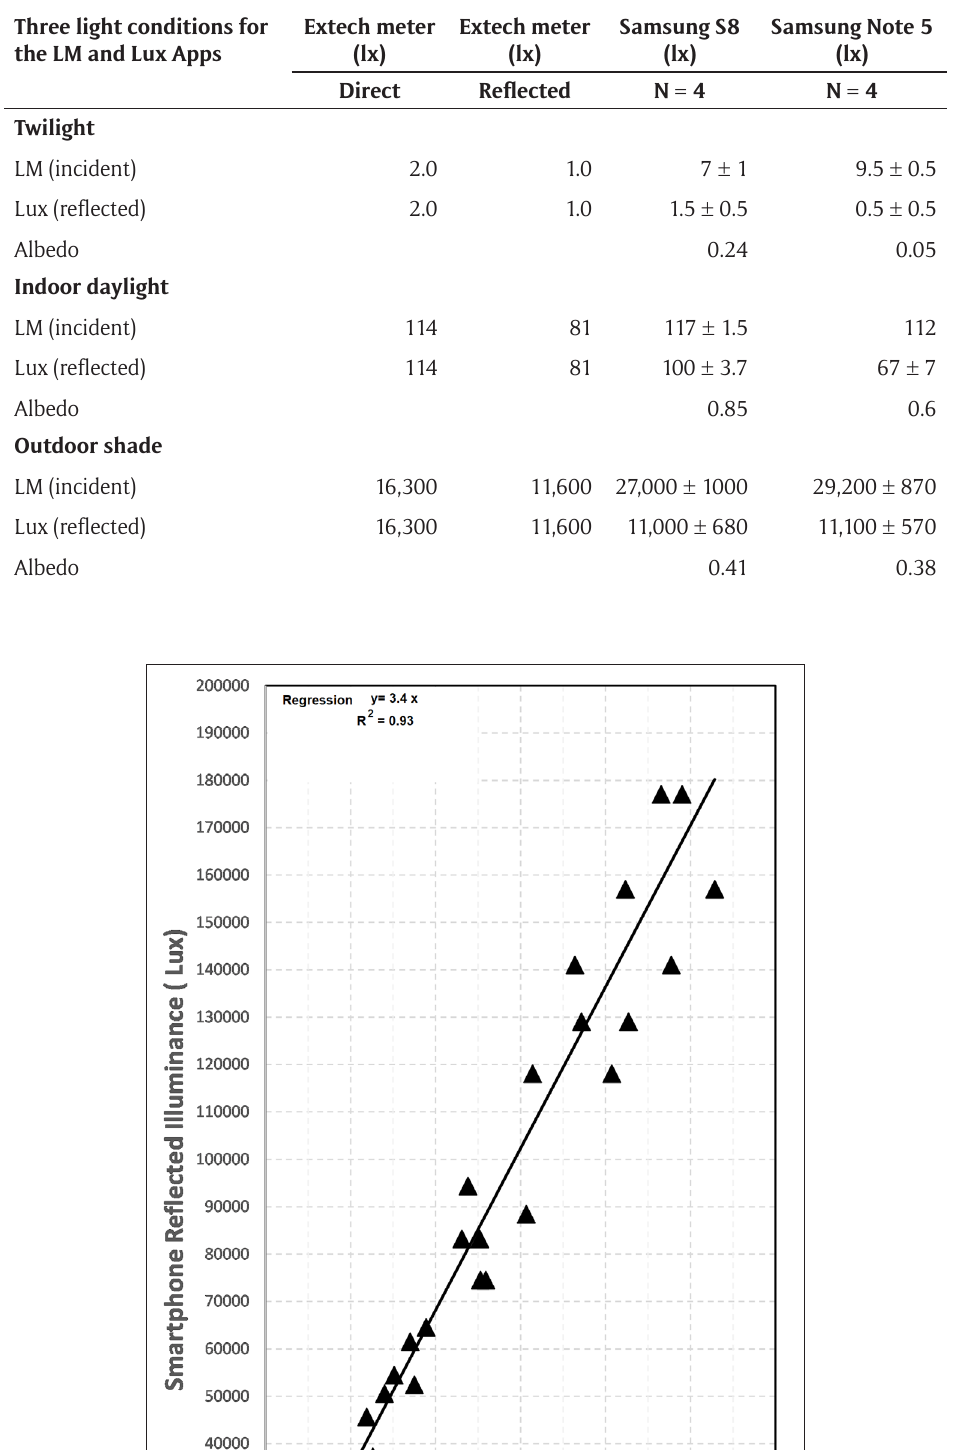
Table 2: Comparisons of standard light-meter readings with two Samsung phones models for three light levels.